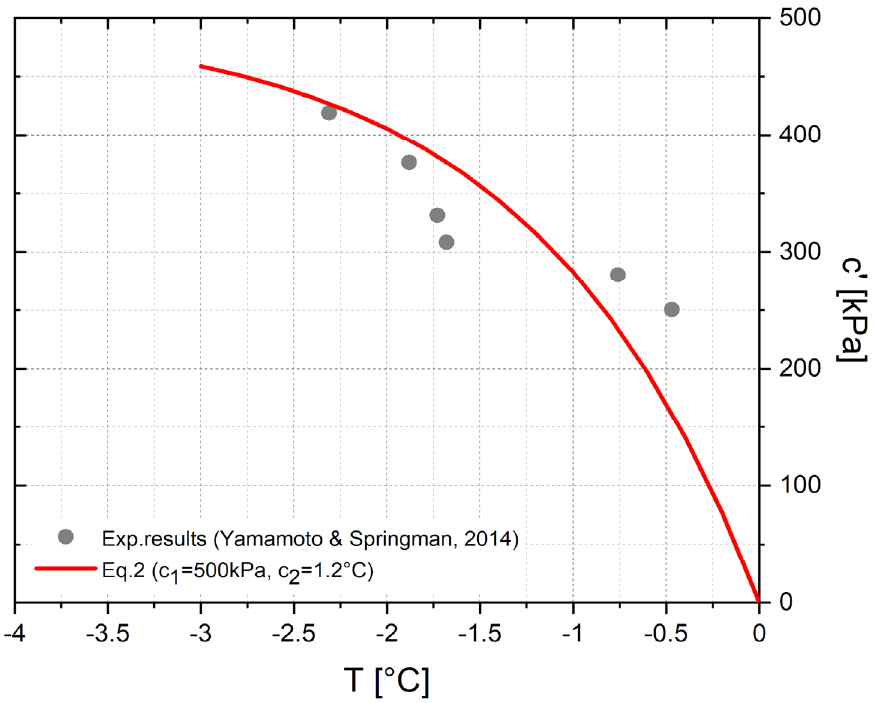
Figure 1. Variation of cohesion with temperature. Gray points represent experimental results from [29], while the red line represents the fitting of the proposed approach.